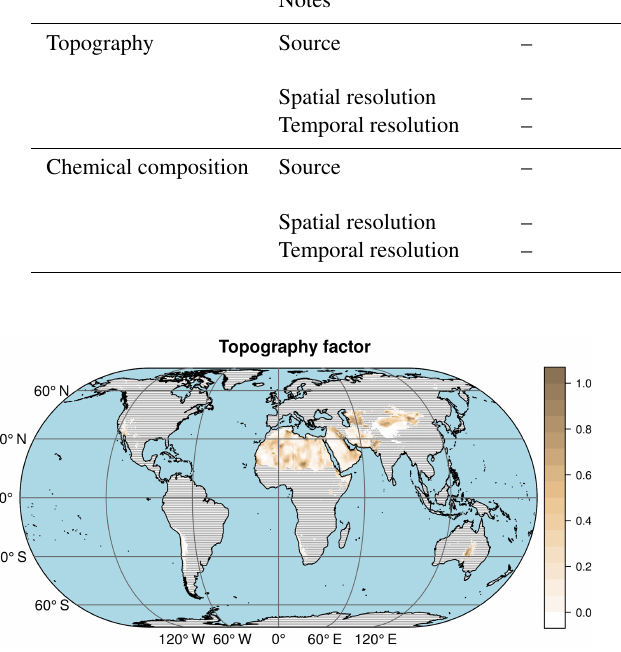
Figure 5. The topography factor defined by Eq. (3), calculated us- ing the GMTED2010 elevation data. Regions where the land cover mask precludes emissions throughout the period of available land cover data (2001 to 2012) are